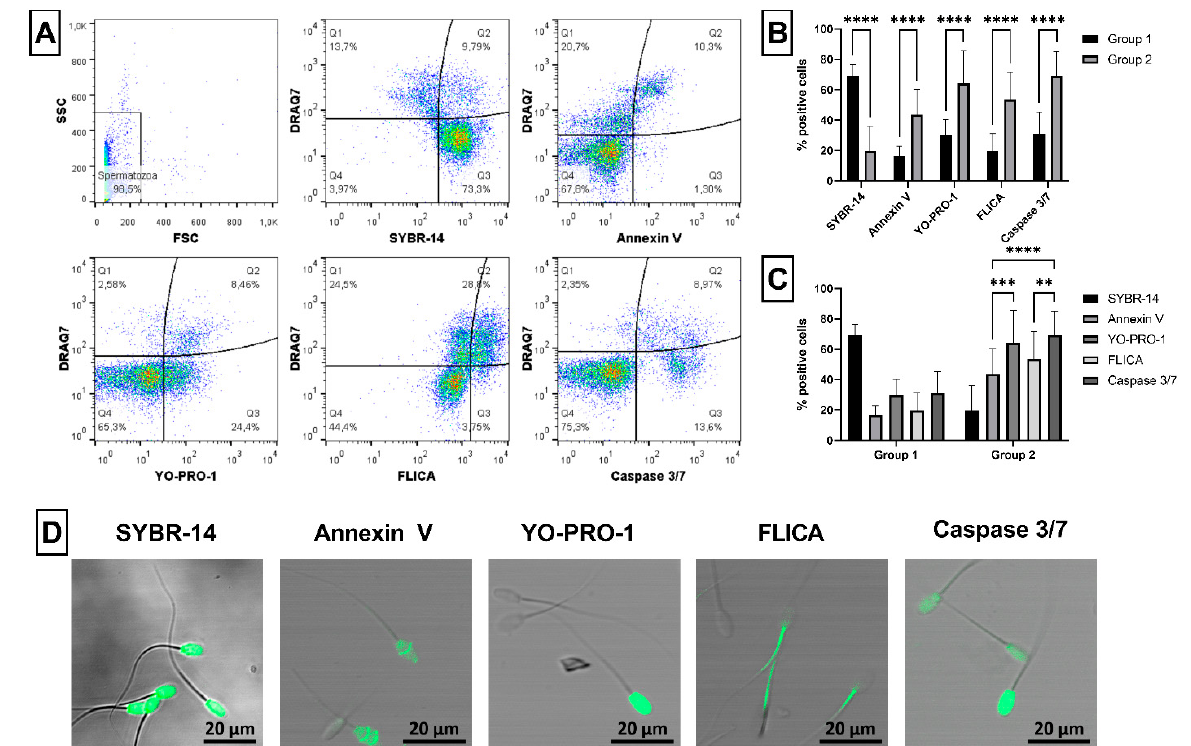
Figure 1. Evaluation of ram sperm viability and apoptosis. Illustrative flow-cytometric dot plots showing evaluation strategy of analyzed fluorescent probes. Firstly, spermatozoa were gated using FSC/SSC dot plot. Then, dot plots showing dead spermatozoa in far-red FL4 channel (DRAQ7 + ) and live (SYBR-14 + ) or apoptotic (Annexin V + , YO-PRO-1 + , FLICA + and Caspase 3/7 + ) spermatozoa in green FL1 channel were created and divided into four quadrants (Q) according to fluorescent signals ( A ). Graph showing comparison of live (Q3: SYBR-14 + /DRAQ7 − ) and apoptotic spermatozoa de- tected using Annexin V (Q2: AnV + /DRAQ7 + and Q3: AnV + /DRAQ7 − ), YO-PRO-1 (Q2: YO-PRO- 1 + /DRAQ7 + and Q3: YO-PRO-1 + /DRAQ7 − ), FLICA (Q2: FLICA + /DRAQ7 + and Q3: FLICA + /DRAQ7 − ), and Caspase 3/7 (Q2: Caspase 3/7 + /DRAQ7 + and Q3: Caspase 3/7 + /DRAQ7 − ) in Group 1 and Group 2 ( B ). Graph comparing proportion of apoptotic spermatozoa detected using four different fluores- cent probes (Annexin V, YO-PRO-1, FLICA and Caspase 3/7) within each group ( C ). Illustrative images from confocal microscopy (Zeiss LSM 700) proving the specific staining of ram spermatozoa with live and apoptotic fluorescent probes (magnification at 200×, scale bar = 20 µm). SYBR-14 spe- cifically labeled DNA in the nucleus of spermatozoa with intact membrane (green), whereas YO- PRO-1 stained the nucleus of apoptotic cells (green). Annexin V labeled deteriorated membranes in different parts of sperm heads (green). FLICA reagent specifically stained active poly caspases in sperm tails (green), while Caspase 3/7 labeled active caspases 3/7 mainly in sperm heads (green) ( D ). Group 1—semen samples with sperm viability over 60%, Group 2—semen samples with sperm viability under 60%. The data are expressed as the means ± SD; difference is statistically significant at ** p < 0.01, *** p < 0.001 and **** p < 0.0001.